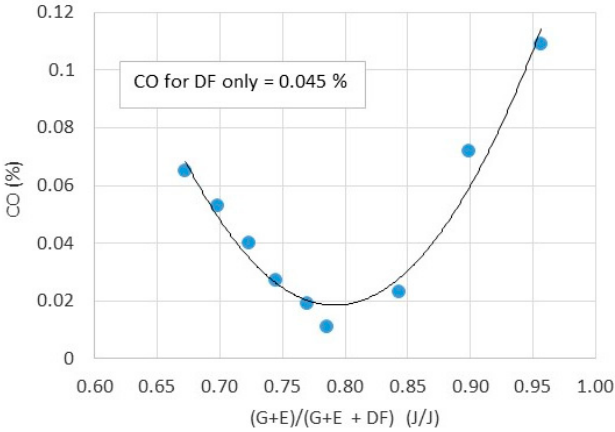
Figure 9. CO vs. G + E fraction by energy Figure 9. CO vs. 𝐺 + 𝐸 fraction by energy content.